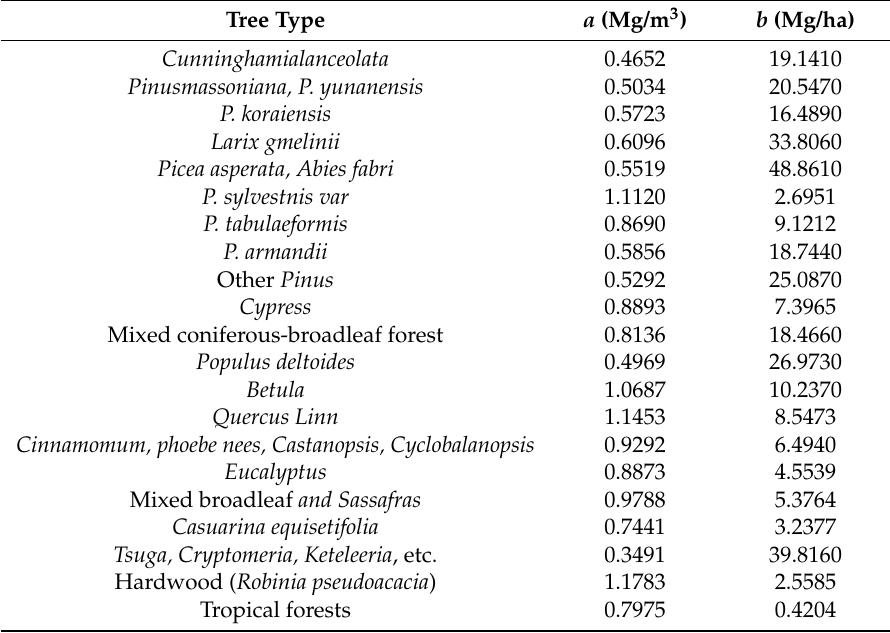
Table 1. Constants of major tree species in China’sarbor